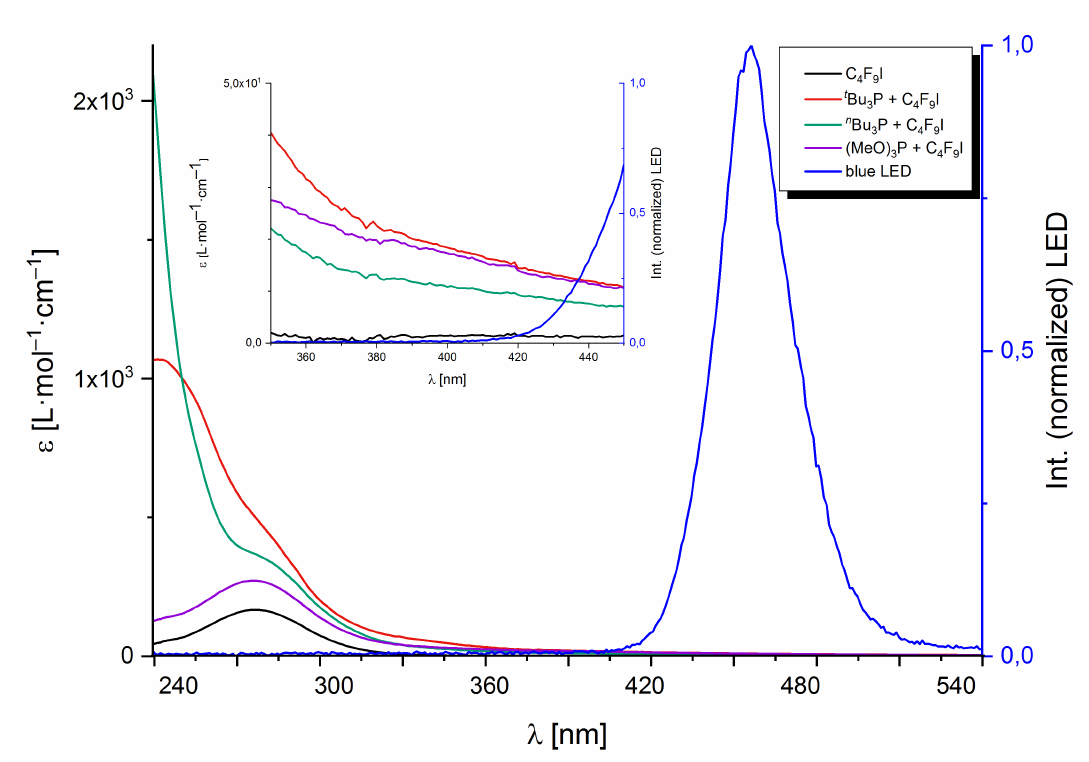
Figure 1. UV-vis spectra of C 4 F 9 I, t Bu 3 P, n Bu 3 P, (MeO) 3 P and mixtures of the phosphorus compounds with C 4 F 9